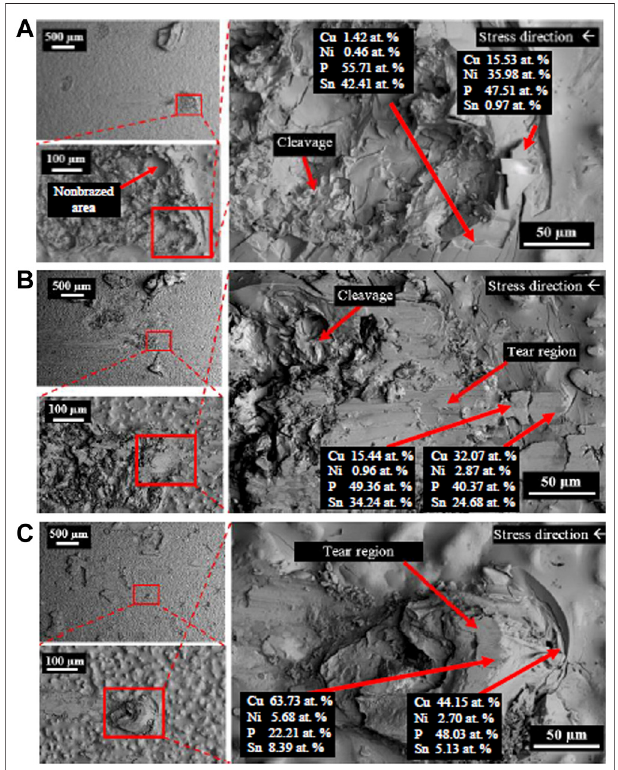
FIGURE 6 | Shear fracture of top-view Cu substrate surface from the brazed Cu/Cu foam shear test with different Cu foam pore densities of (A) foam A, (B) foam B, and (C) foam C.